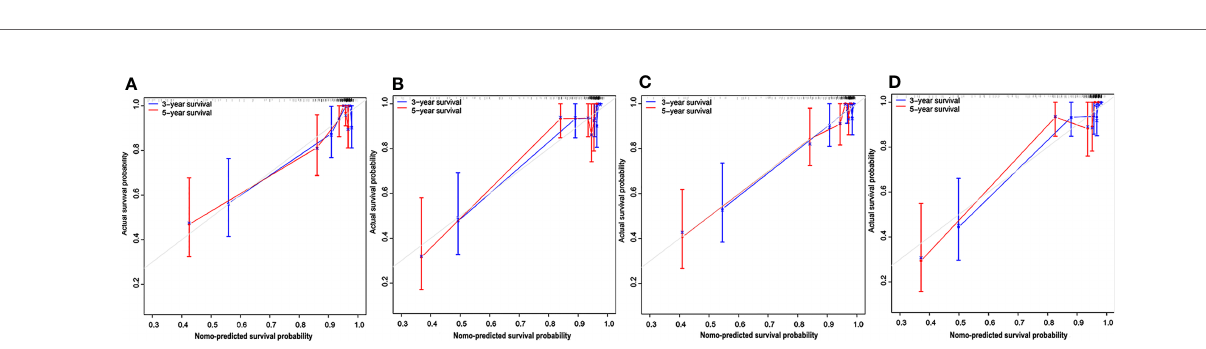
FIGURE 6 | Calibration curves for the nomograms. Calibration curves for the clinical nomogram in the training (A) and test (B) cohorts. The y-axis indicates the actual probability of survival; the x-axis indicates the predicted probability of survival. The 45-degree gray line represents the ideal prediction; blue and red lines represent the performance of the clinical nomogram to predict 3- and 5-year survival, respectively. Calibration curves for the radiomics nomogram in the training (C) and test (D) cohorts. Nomo-predicted, nomogram-predicted.